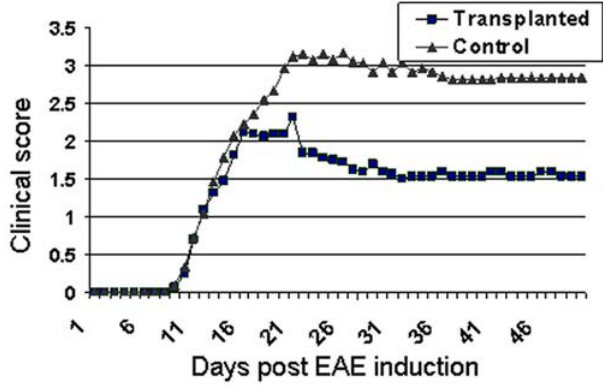
Figure 2. The clinical course of EAE is attenuated after transplantation of hESC-derived NPs. hESC-derived NPs were transplanted into the lateral brain ventricles of EAE mice and the severity of clinical signs was scored daily. A significant attenuation of the clinical score was observed in NPs-transplanted animals ( & ) in comparison to vehicle-transplanted control animals ( m ). The reduced severity of clinical scores in NP-transplanted animals was evident as early as the acute phase of the disease (day 19 post-EAE induction). See material and methods section for details regarding the clinical scoring system.